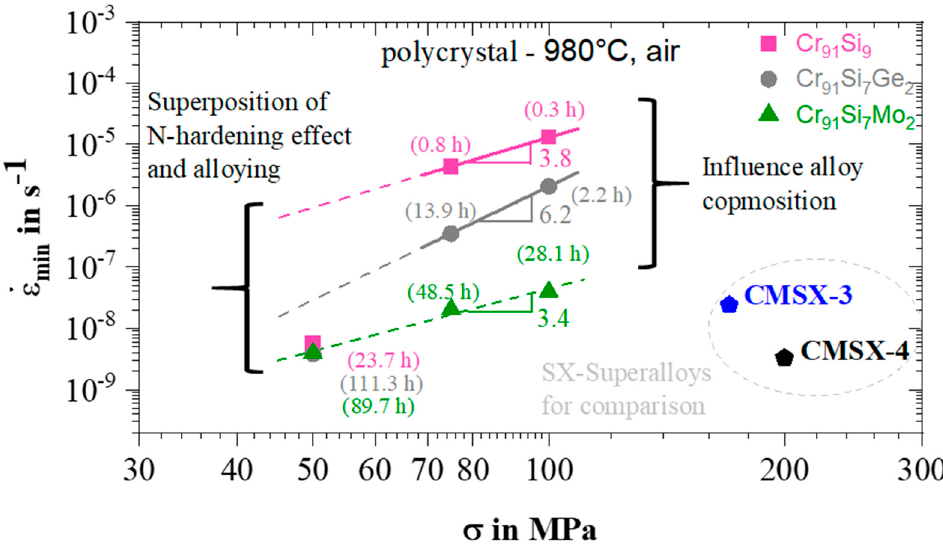
Figure 6. Norton-plot of the tested polycrystalline alloys in comparison with the single crystalline Ni base superalloys CMSX-3 and CMSX-4 [33]. Values in brackets represent the time to reach minimum creep rate (t min creep). It should be noted that comparison is made between polycrystalline materials of this study and single crystalline Ni-base superalloys.